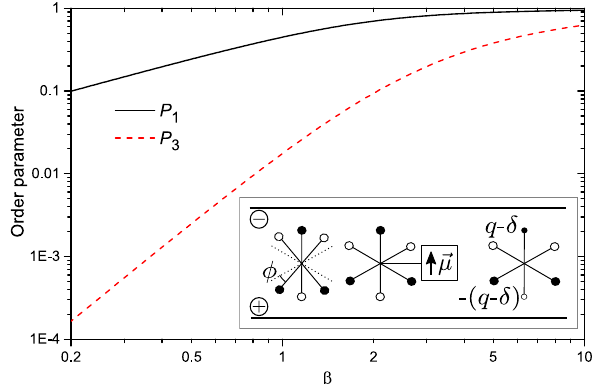
Figure 6. Log-log plot of octupolar order parameters P 1 (black solid line) and P 3 (red dashed line) in function of the inverse temperature β ∗ d . Inset: modified dipolar–octupolar molecules, see